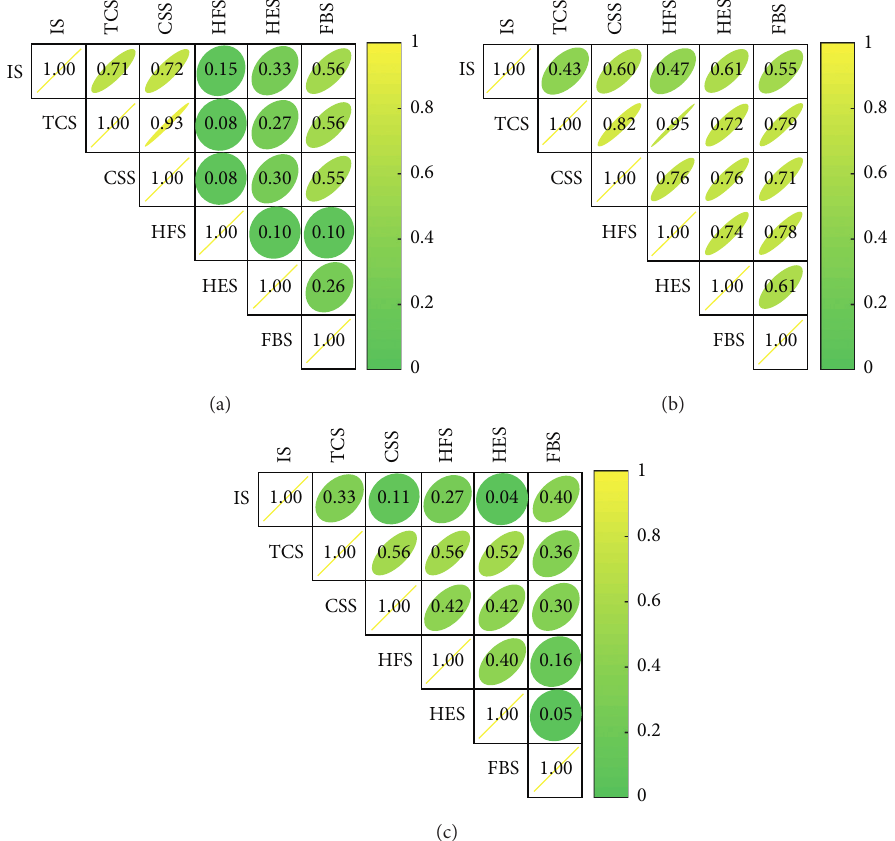
Figure 6: Pearson correlation coefficient of the retail categories in the three commercial districts: (a) Chongqing Road; (b) Hongqi Street; (c) Guilin Road.